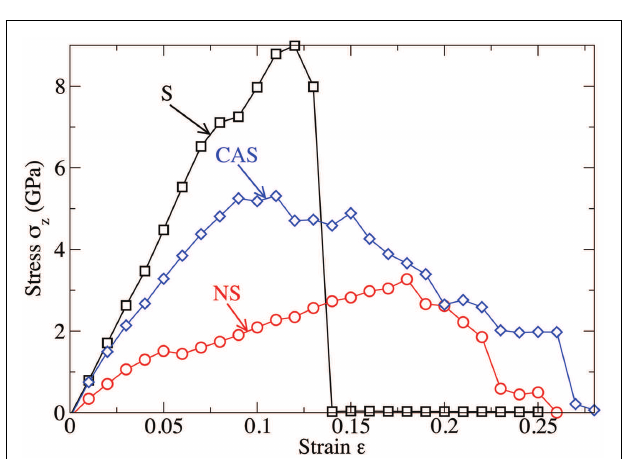
FIGURE 6 | Computed stress as a function of the tensile strain imposed to the system, for silica (S), sodium silicate (NS), and calcium aluminosilicate (CAS) glasses, respectively